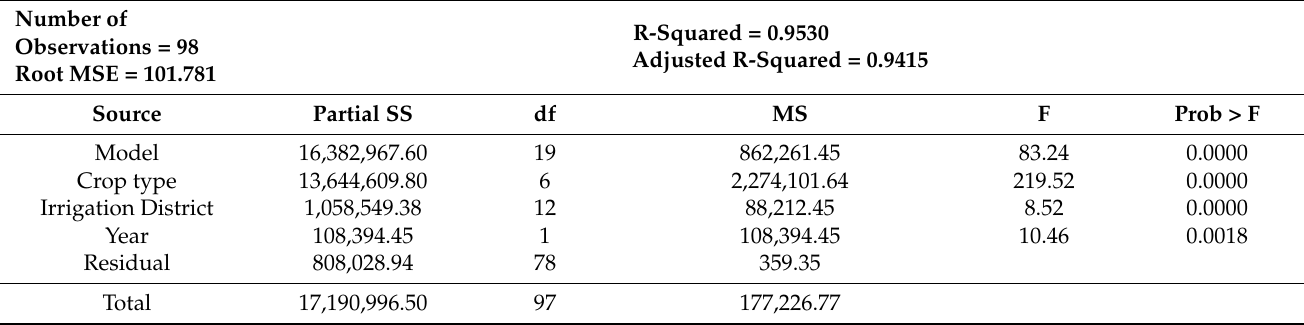
Table 4. Statistical significance test of difference in crop water use between dry and wet